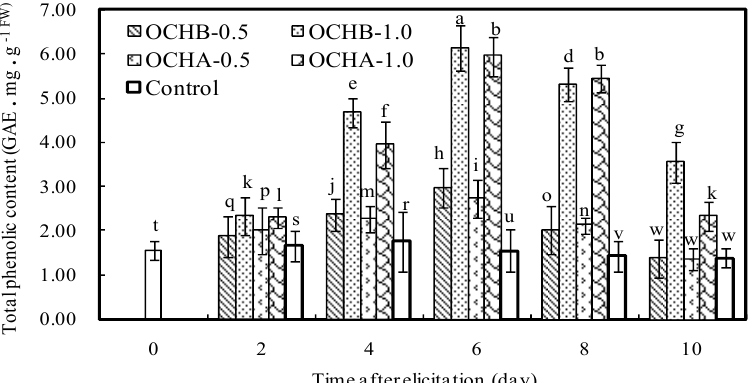
Figure 3. Effects of OCHA and OCHB on total phenolics in Z. bungeanum twig. The error bars represent standard deviations of the means from three independent samples. Values followed by different letters indicated significant differences among the different treatments at p = 0.05 level. FW means fresh weight of plant